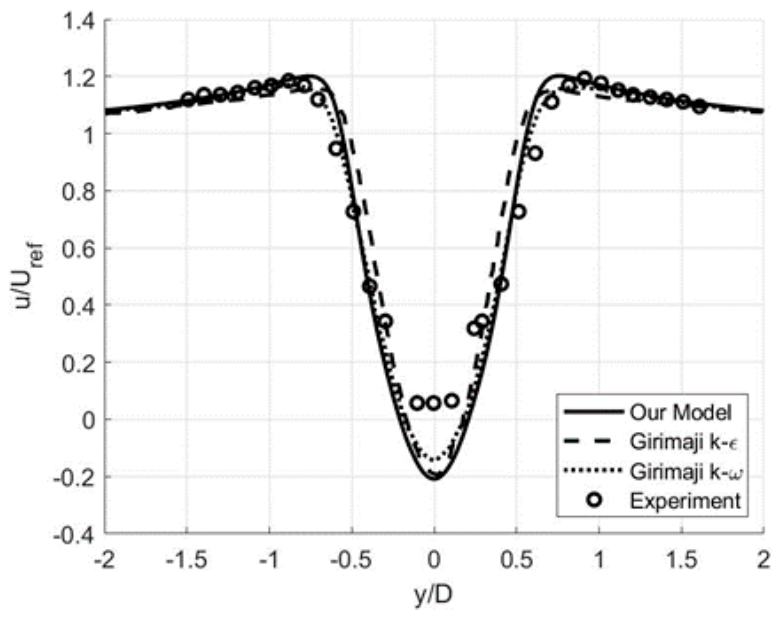
Figure 17. The mean streamwise velocity profile at x / D = 1 ( f ε = 1.0, f k = 0.5 ) .